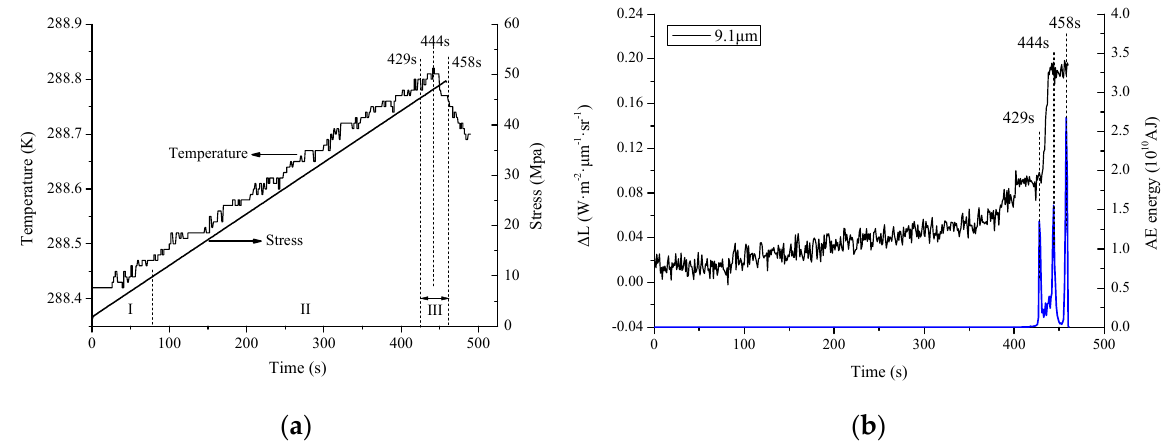
Figure 3. ( a ) Temperature variation curve and stress curve of sample sy20–3; ( b ) spectral radiance variation curve at 9.1 μ m and AE energy curve of sample sy20–3 with the fracture mode of extensional fissures.